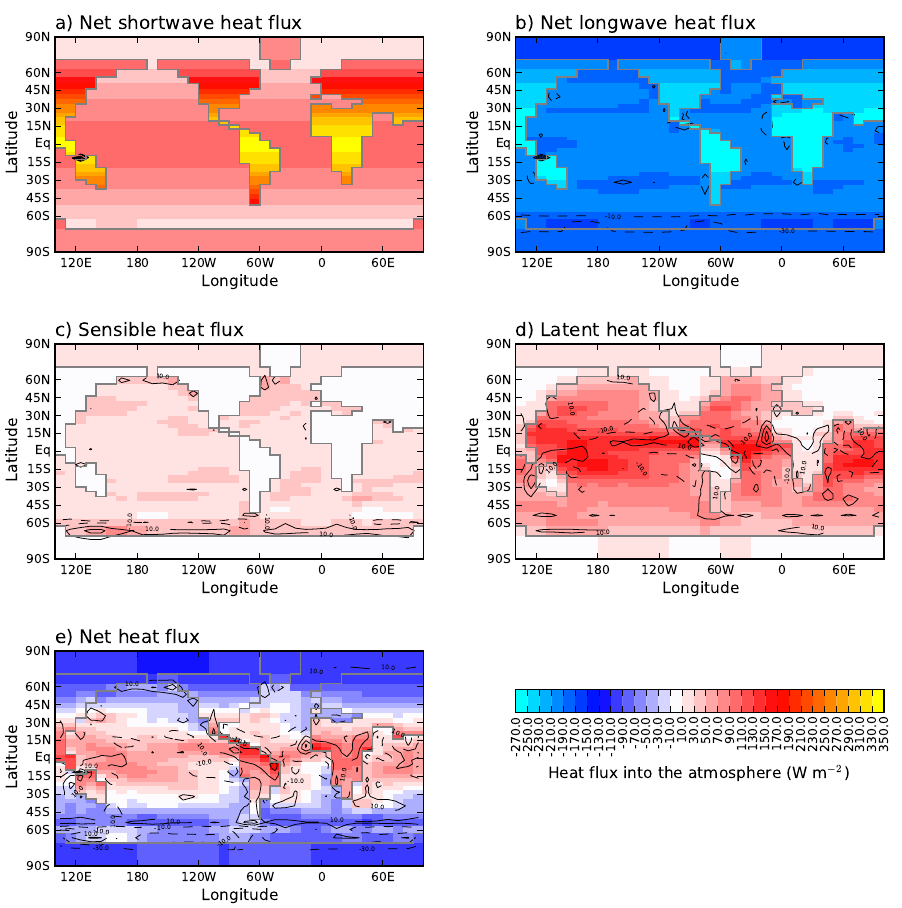
Fig. 16. Annual-mean components of heat flux (W m − 2 ) into the atmosphere for 3636s16l (maps) and “3636s16l” minus “biogem” differ- ences